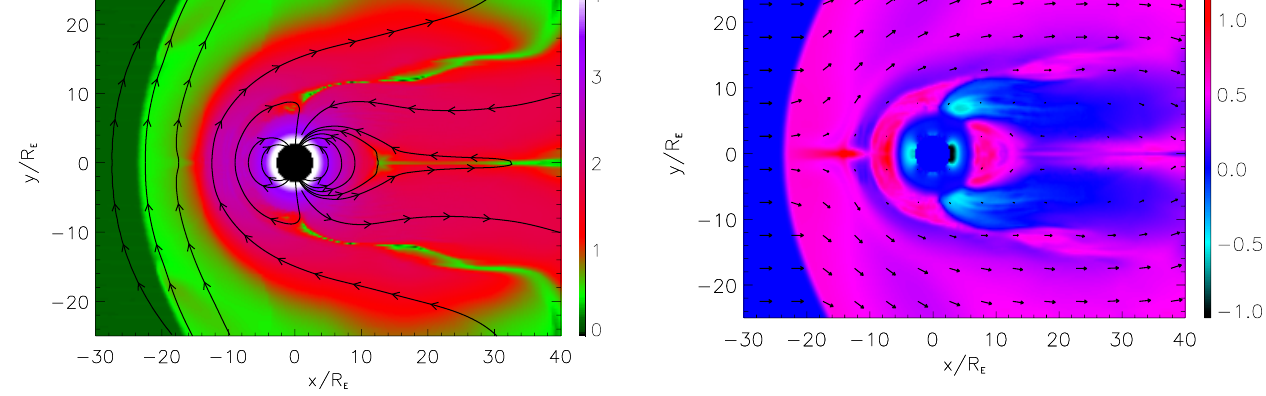
Fig. 7. Variation of the plasma density, here represented by log 10 (n) , is shown with velocity vectors superimposed. See cor- responding Fig. 6 for the magnetic field.